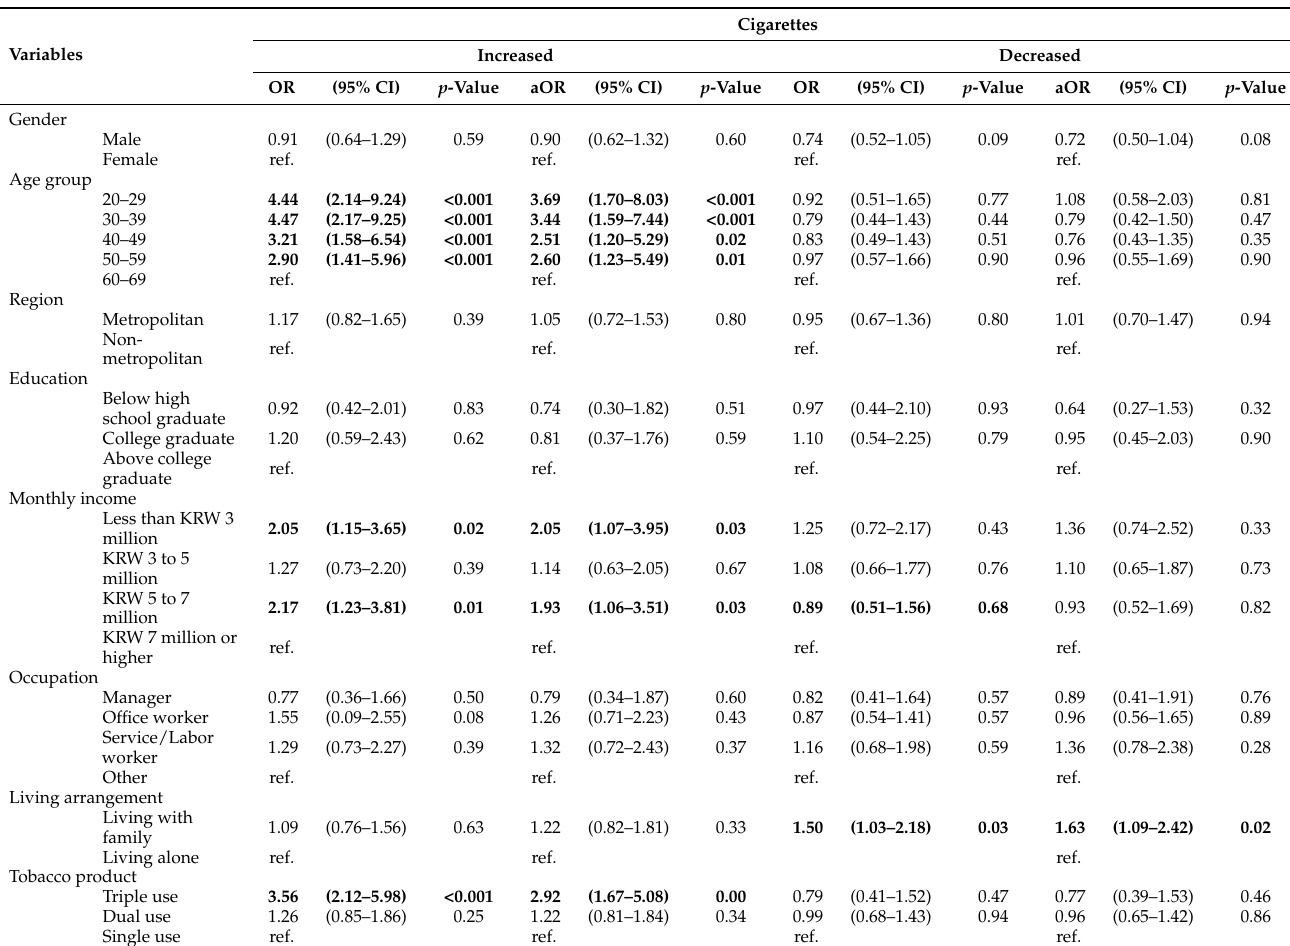
Table 3. Factors associated with the subjective change in usage of